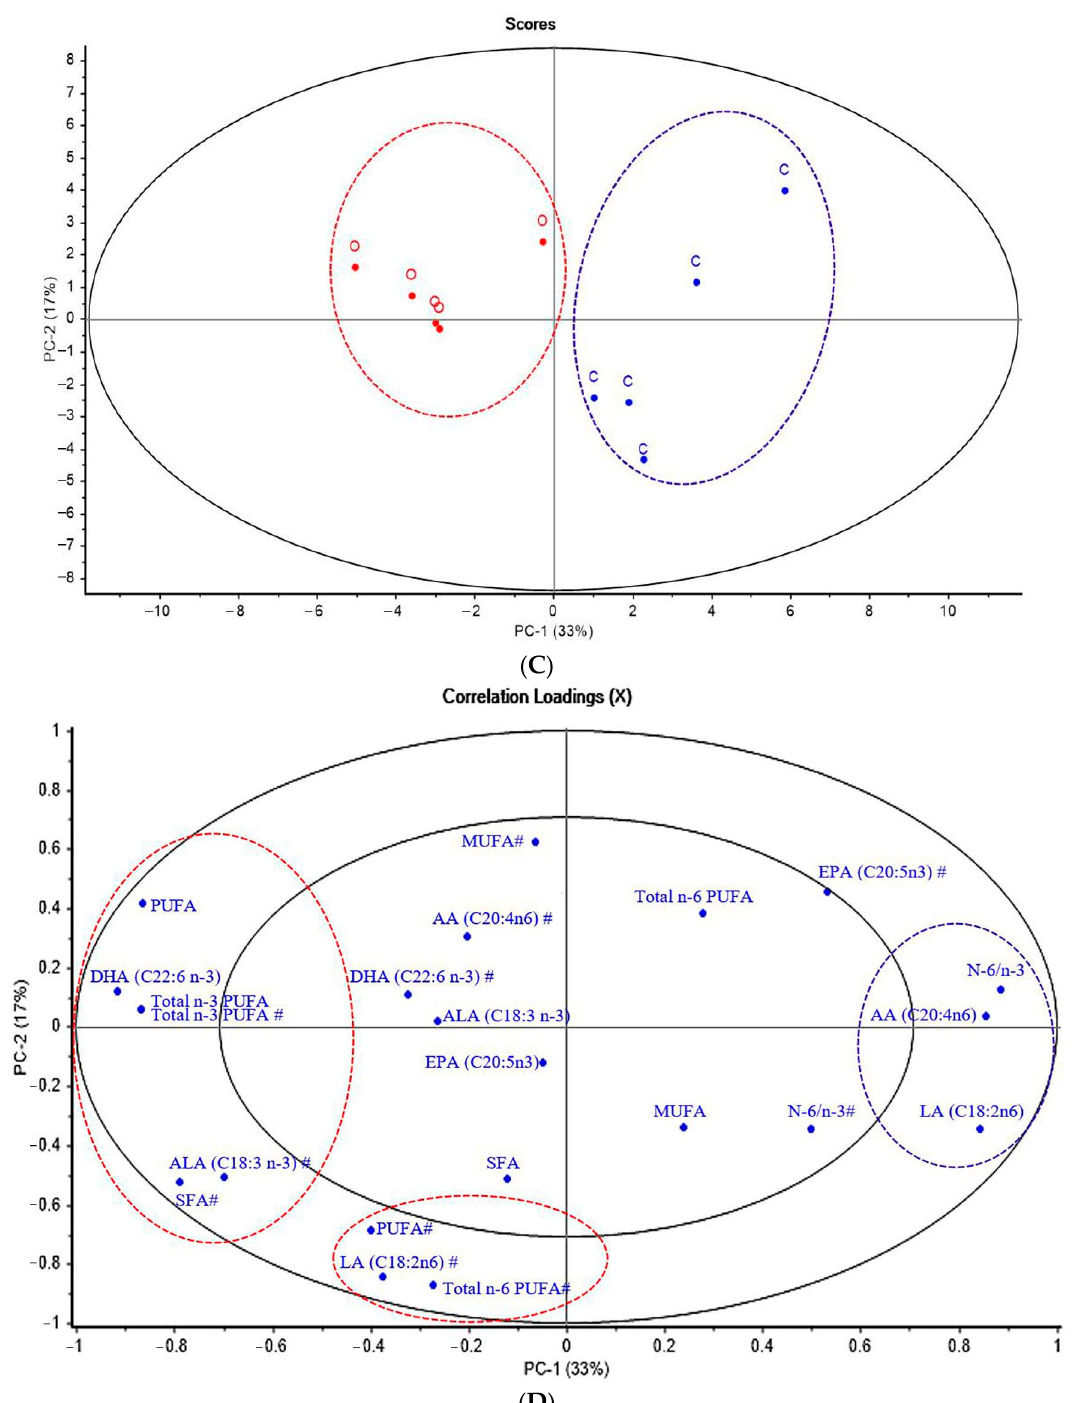
Figure 2. Principal component analysis ( P CA) score plot and correlation loading plot (PC - 1 vs. PC-2) of SR - FTIR spectra, biochemical compounds and meat quality ( A , B ) and fatty acid in breast and thigh meat ( C , D ) of KRC in different production systems. Abbreviations: C, control group; O, organic group; Am I, amide I of protein; Am II, amide II of protein, Am III, amide III of collagen, CP, crude protein; a*, redness; b*, yellowness; L*, lightness; a* S , redness of skin; b* S , yellowness of skin; L * s , lightness of skin; SFA, saturated fatty acids; PUFA, polyunsaturated fatty acids; MUFA, monounsaturated fatty acids; α -linolenic acid; DHA, docosahexaenoic acid; EPA, eicosapentaenoic acid; LA, linoleic acid; # = thigh meat, without # = breast meat.